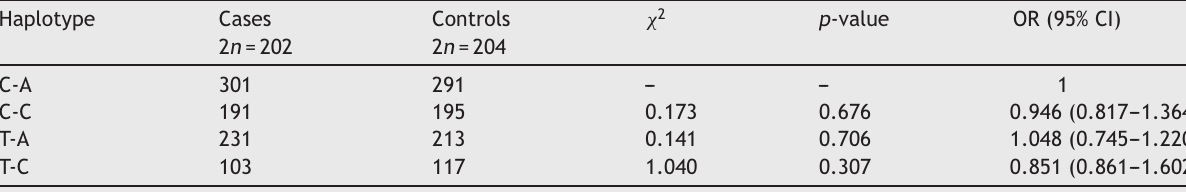
Linkage disequilibrium and haplotype analysis for alleles of C677T and A1298C polymorphisms.